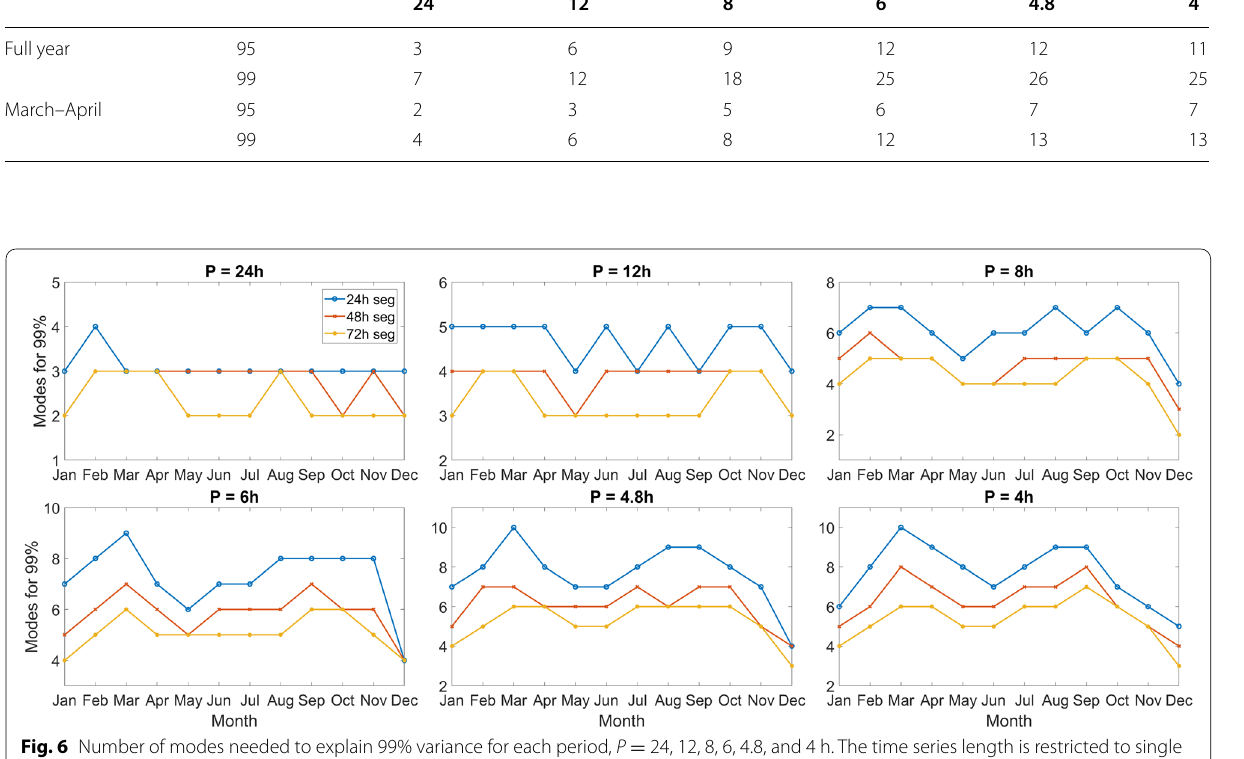
24, 12, 8, 6, 4.8, and 4 h. The time series length is restricted to single =